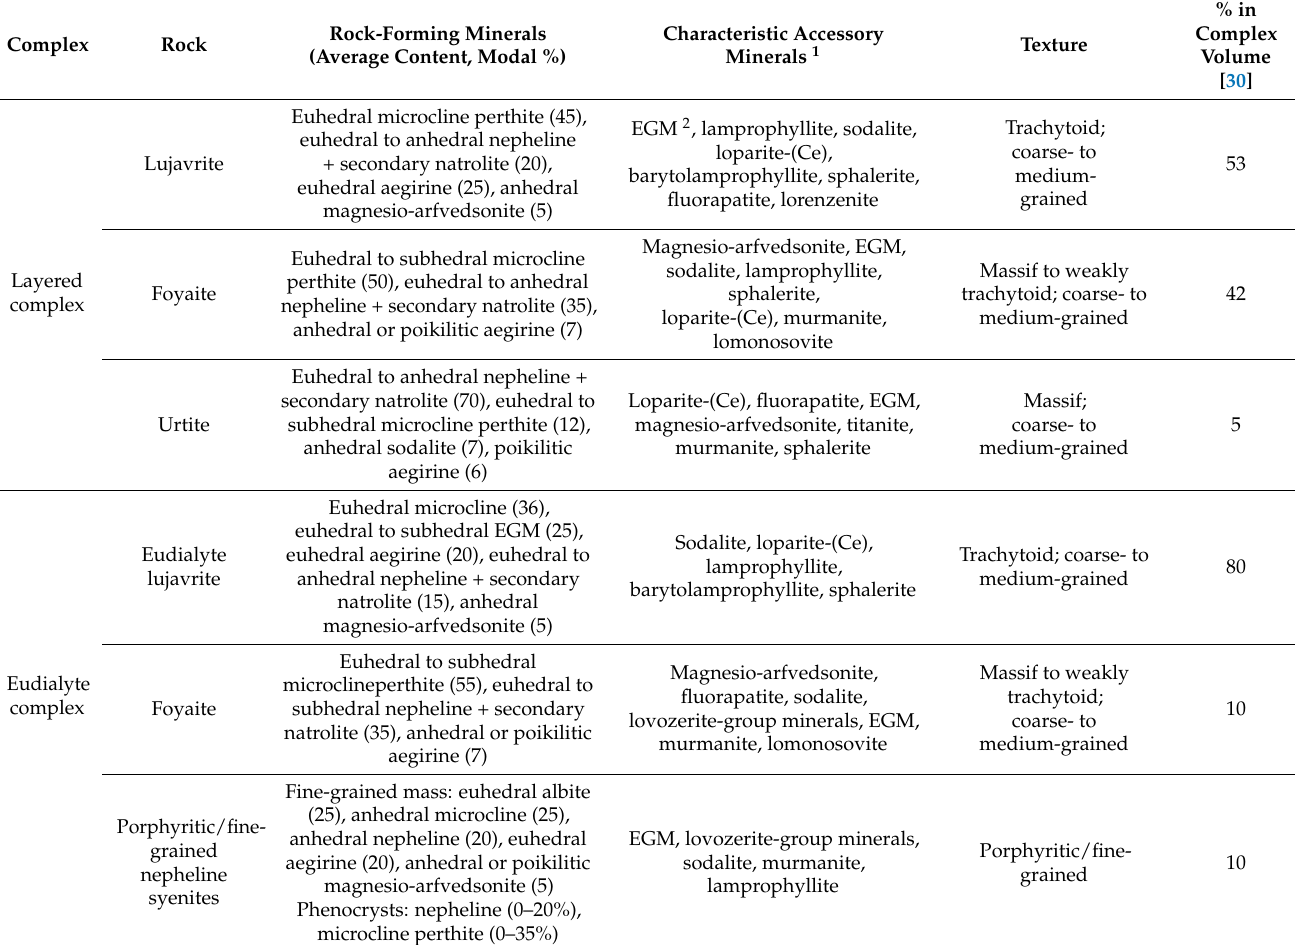
Table 1. Summary of the petrography of the Layered and Eudialyte